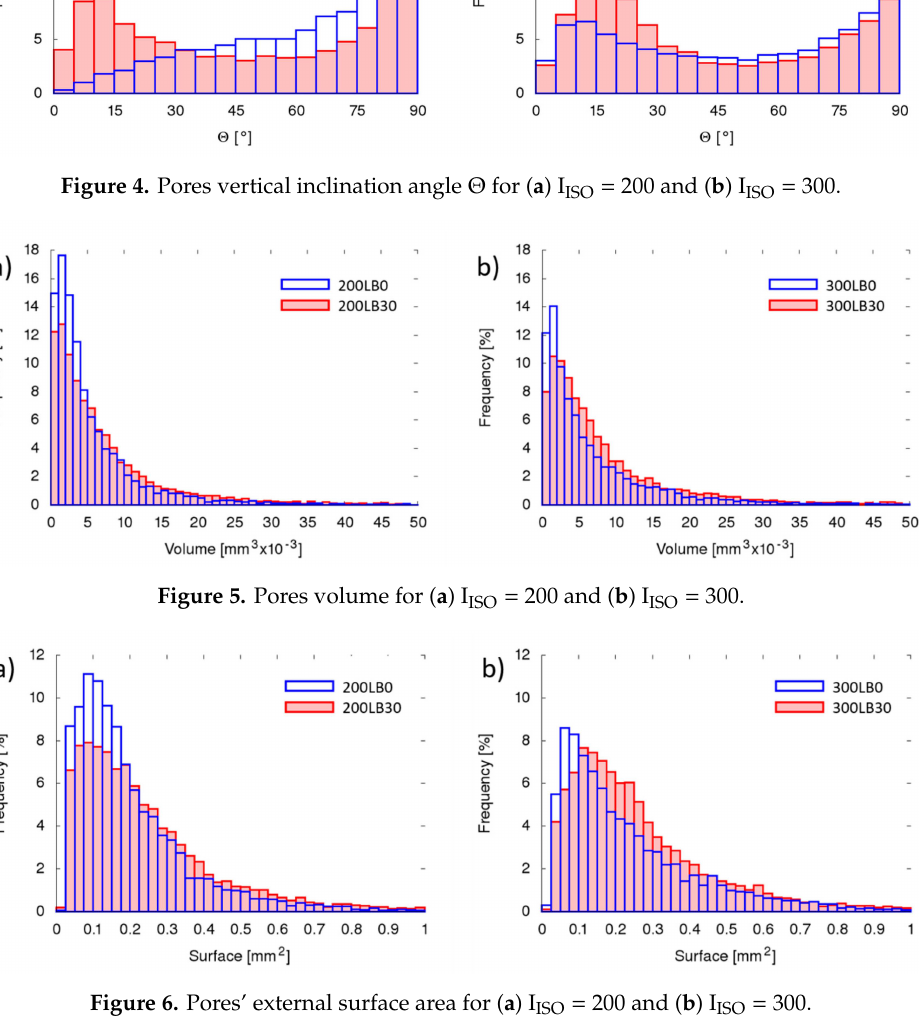
Figure 6. Pores’ external surface area for ( a ) I ISO = 200 and ( b ) I ISO =